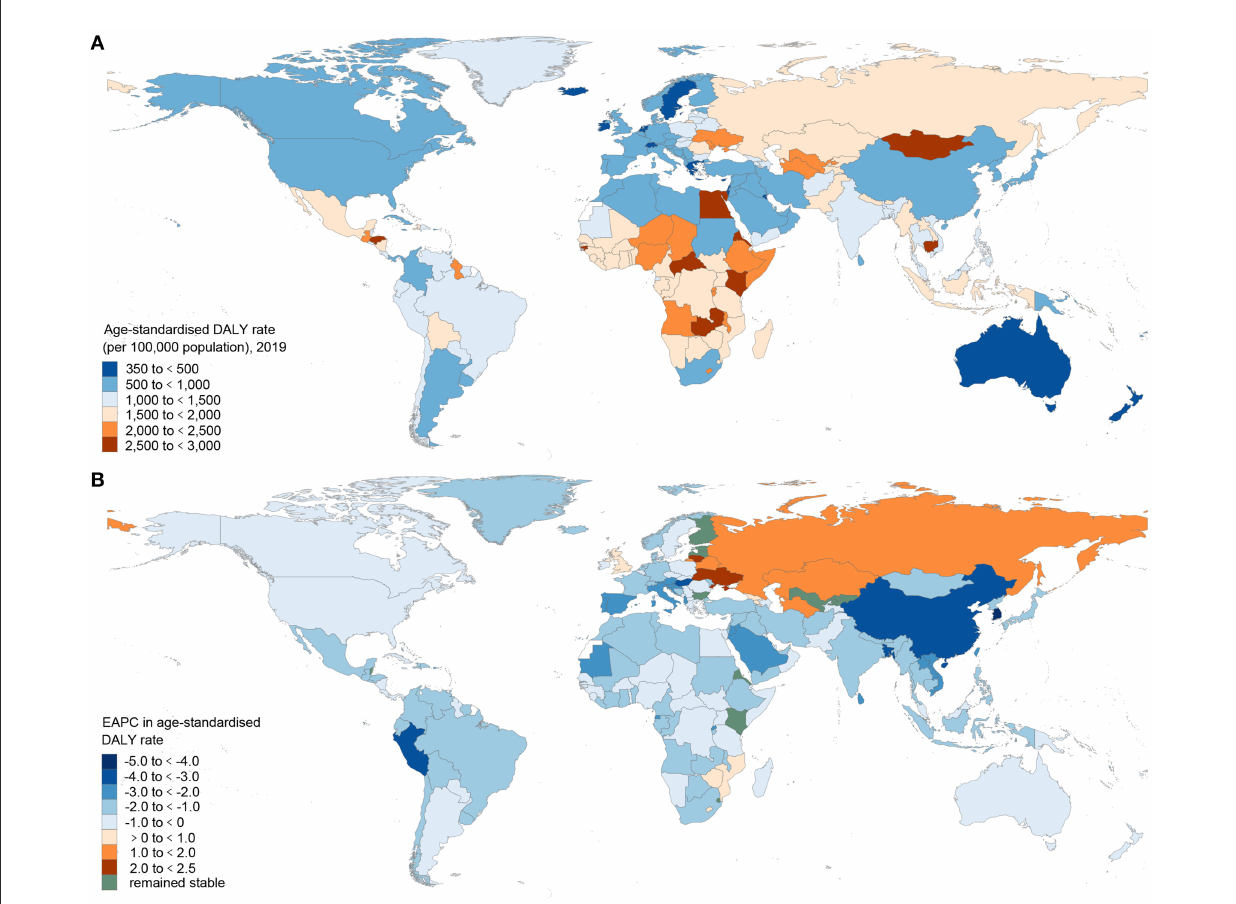
FIGURE1 The global DALY burden of digestive diseases in 204 countries and territories. (A) The age-standardized DALY rate (per 100,000 population) of digestive diseases in 2019. (B) The EAPC of the age-standardized DALY rate for digestive diseases between 1990 and 2019. DALY, disability-adjusted life-year; EAPC, estimated annual percentage